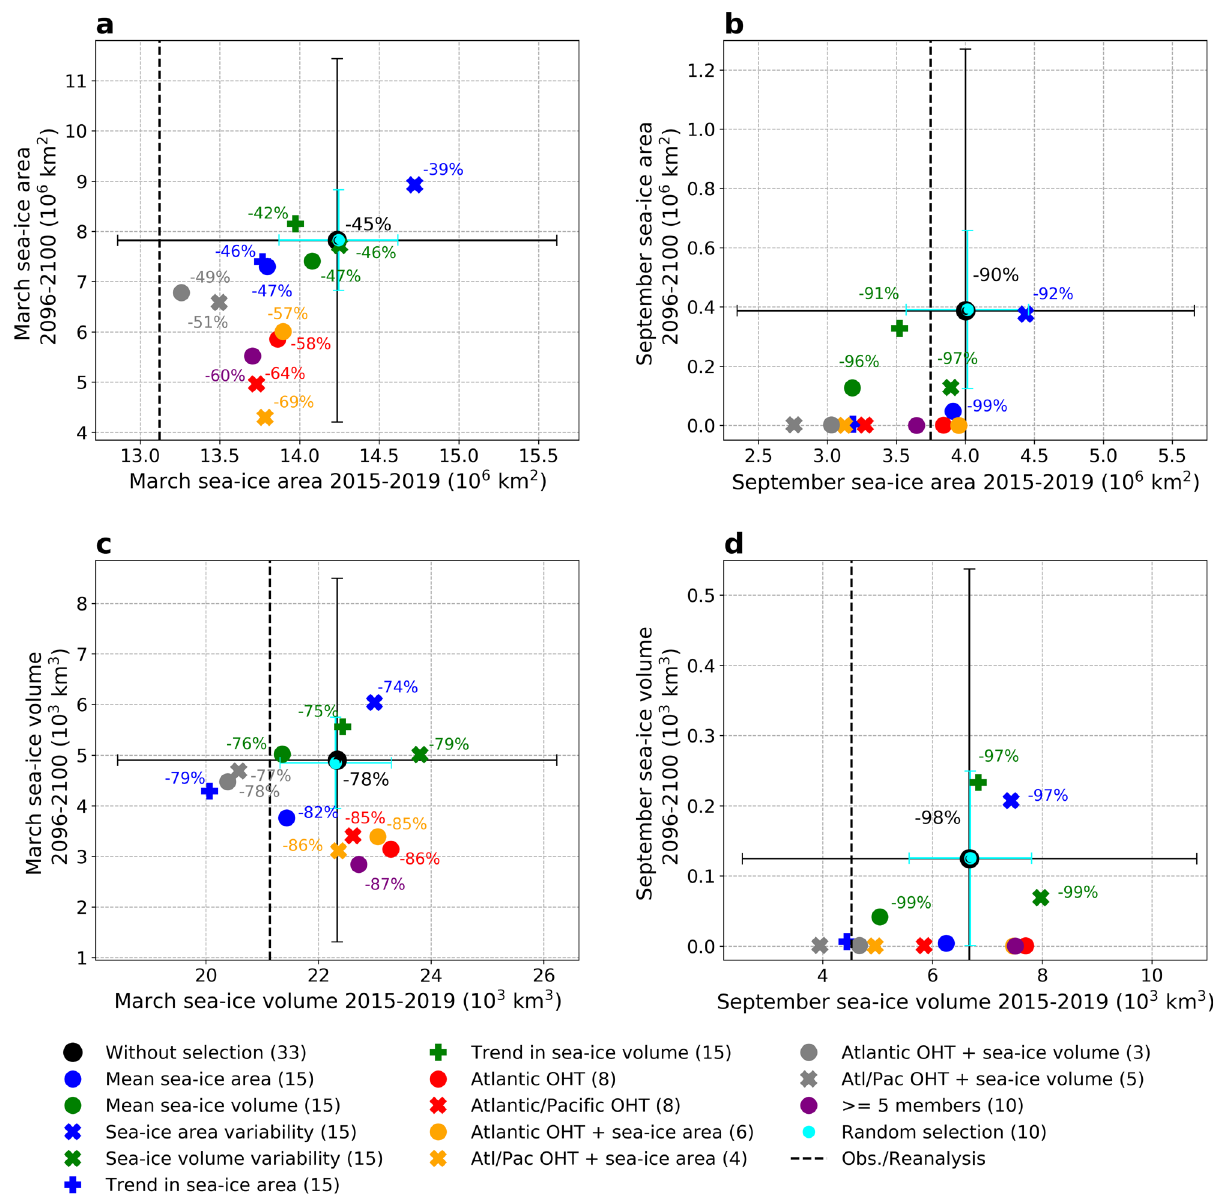
Fig. 3 Arctic sea-ice area and volume in 2096 – 2100 against 2015 – 2019. Quantities are provided for the CMIP6 multi-model mean averaged over all models (black dot, with the ensemble standard deviation as error bars), the multi-model mean averaged over a 10-model random selection (cyan dot with the corresponding error bars for 1000 realizations) and the multi-model means averaged over the models selected according to different criteria (coloured dots and crosses), based on the SSP5-8.5 scenario. a March Arctic sea-ice area, b September Arctic sea-ice area, c March Arctic sea-ice volume, d September Arctic sea-ice volume. The relative change in sea-ice area/volume between 2015 and 2019 and 2096 and 2100 is shown beside the different items (not indicated if the change is − 100%). The dashed vertical lines show ( a , b ) the sea-ice area from OSI SAF observations and ( c , d ) sea-ice volume from PIOMAS reanalysis in 2015 – 2019. The number of models included in each multi-model average is indicated in parenthesis in the